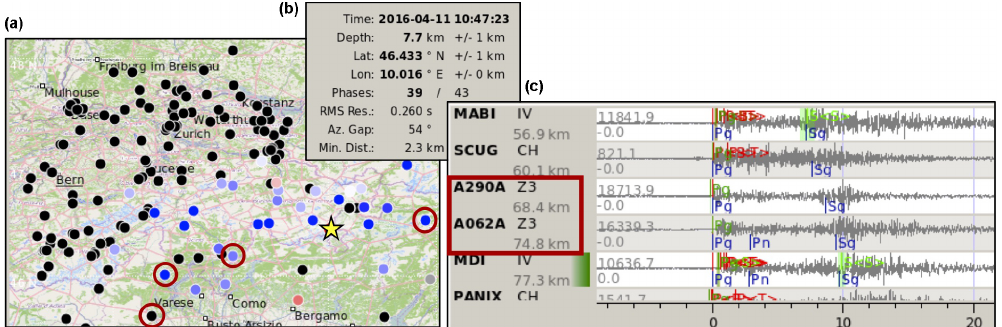
Figure 9. Location solution of the Poschiavo (Switzerland) M3.2 event occurred on 11 April 2016 calculated at the Swiss Seismological Service (SED-ETHZ). At least four AlpArray stations are used to improve the location and to fill the south gap. Green lines are manually detected Pg and Sg picks. The location procedures are performed using SeisComp3